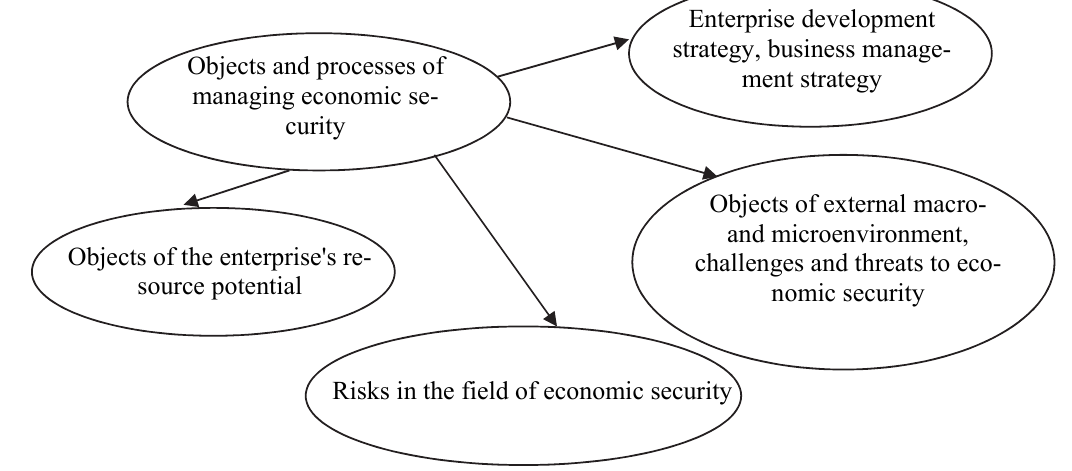
Fig. 1. Objects and processes of managing the enterprise economic